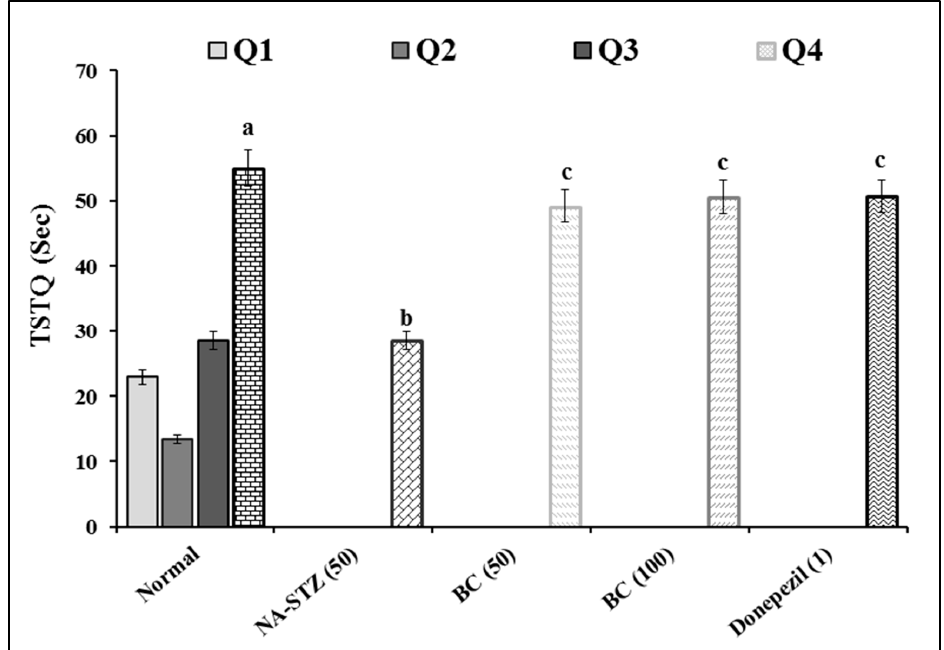
Figure 2. Effect of BC on TSTQ in MWM. Digits in parenthesis indicated dose in mg/kg. Data were expressed as mean ± SD; n = 12 rats. a p < 0.05 vs. the time spent in Q1 of normal group; b p < 0.05 vs. TSTQ (Q4) of normal group; c p < 0.05 vs. TSTQ (Q4) of VaD group. Abbreviations: BC, beta-carotene; NA, nicotinamide; Q, quadrant; STZ, streptozotocin; TSTQ, time spent in target